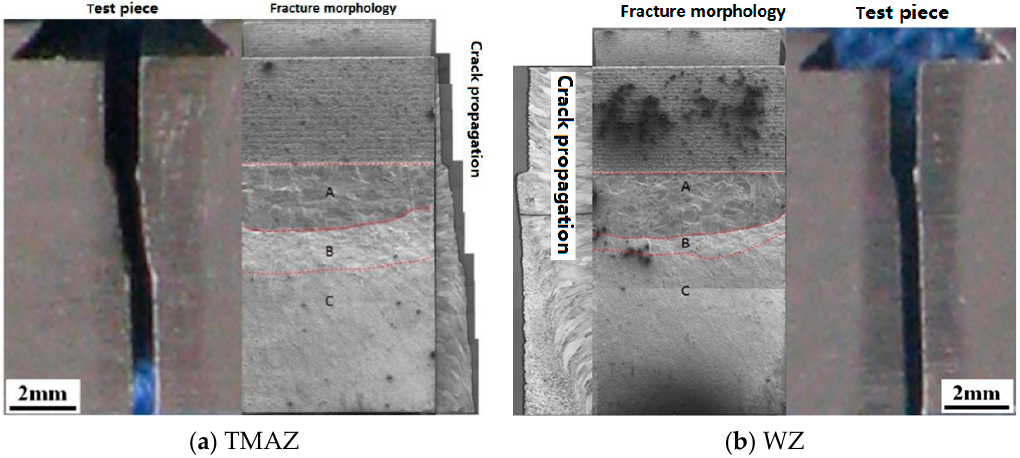
Figure 13. Fracture morphology of the test piece and crack propagation direction.